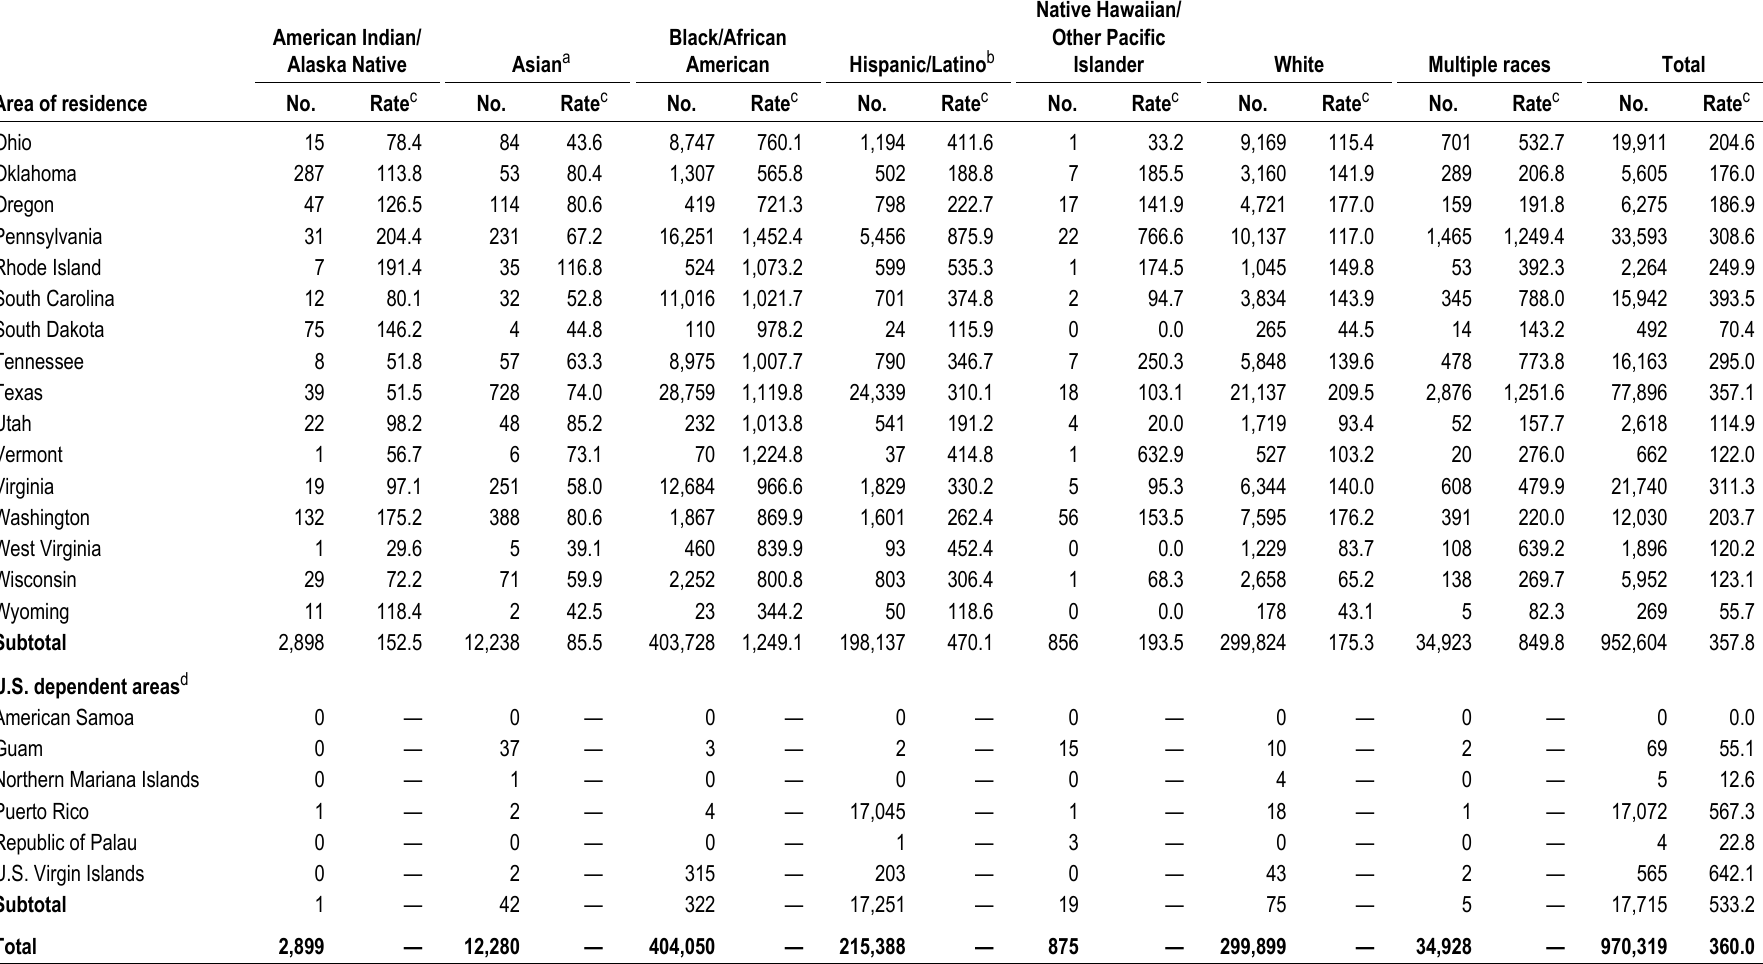
Table 24. Adults and adolescents living with diagnosed HIV infection, by race/ethnicity and area of residence, year-end 2014—United States and 6 dependent areas